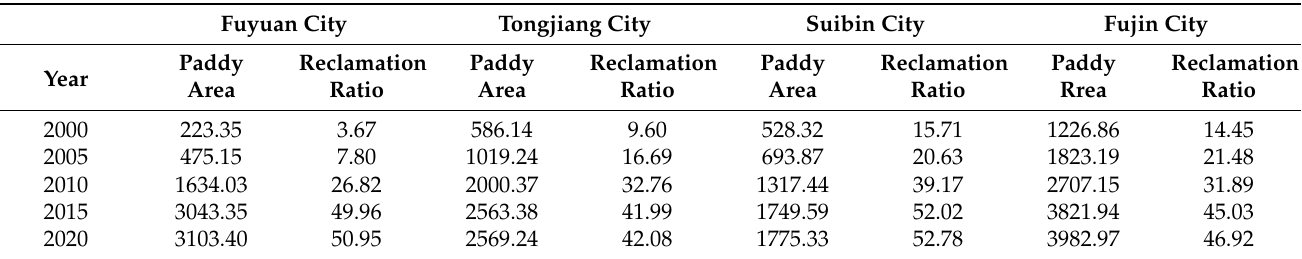
Table 1. Paddy land area and corresponding reclamation rate in each administrative region in the years 2000, 2005, 2010, 2015 and 2020 (area: km 2 , reclamation ratio: